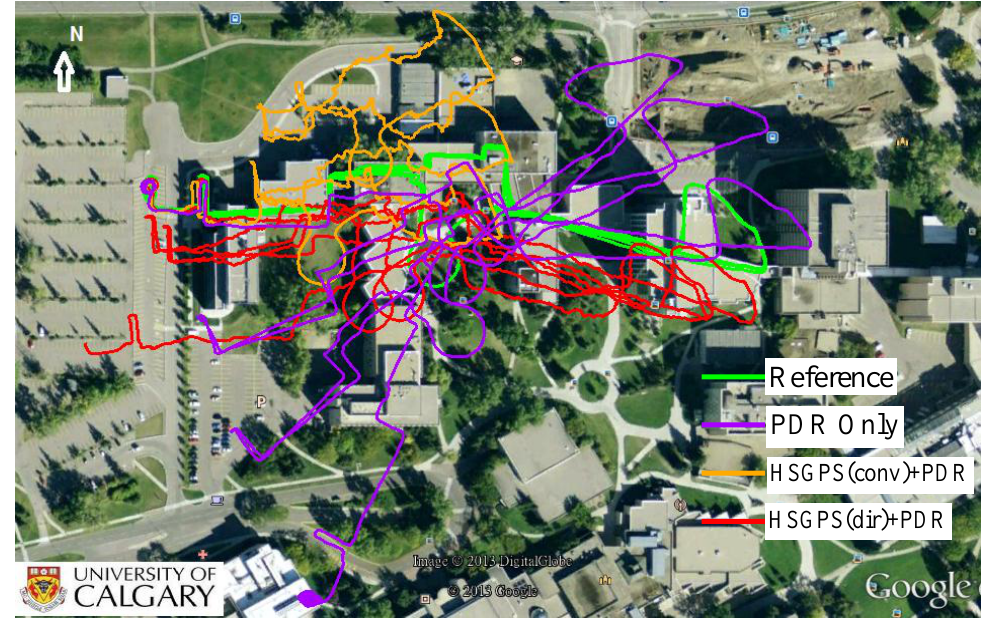
Figure 10. Trajectories of various navigation solutions.